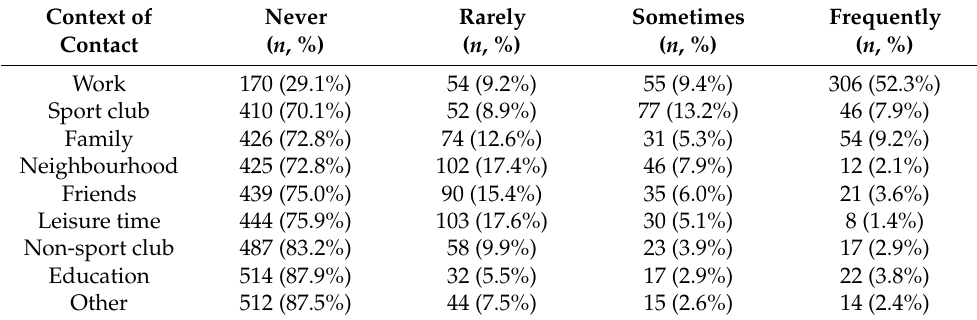
Table 4. Frequency of self-reported contact with people with an ID in different context